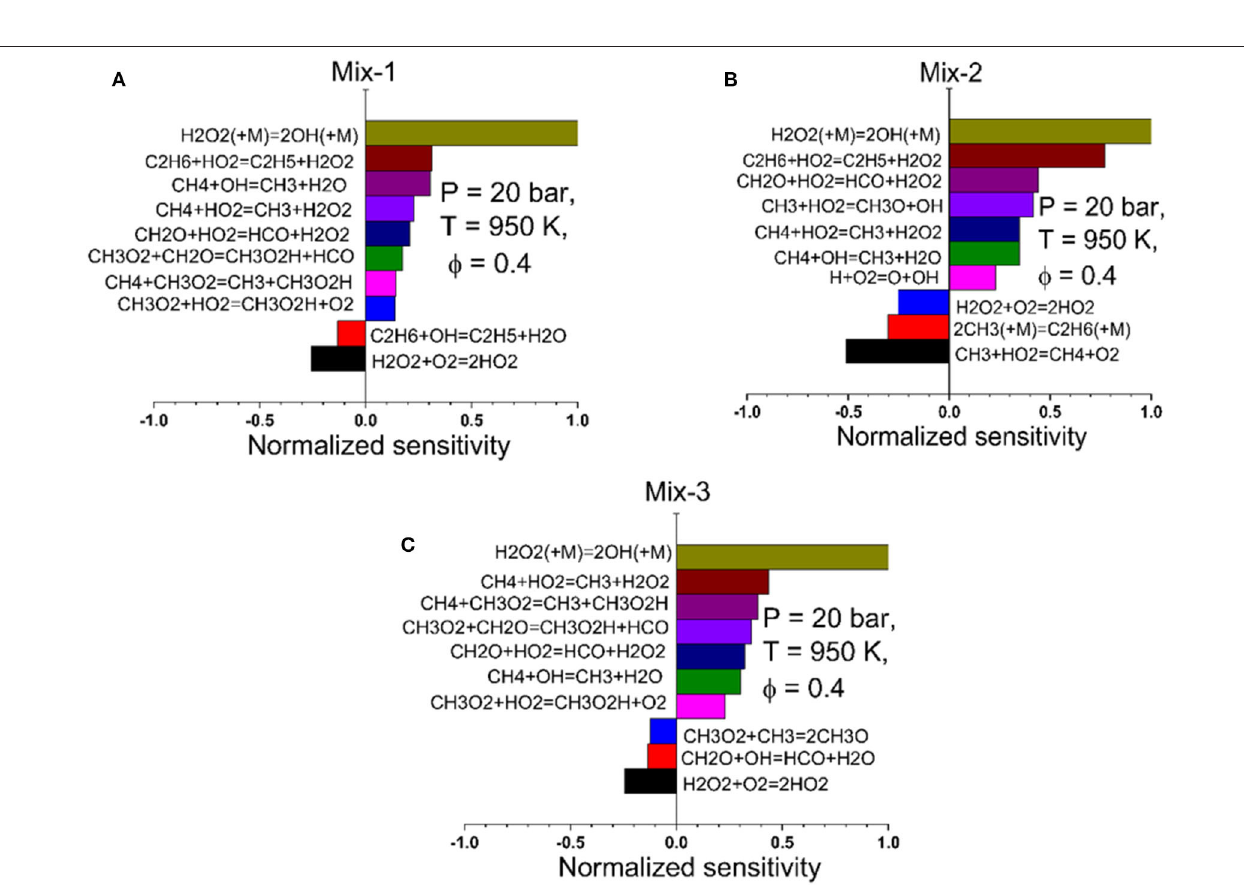
(Zhang et al., 2015) was performed to gain insights on the ignition behaviors. The following findings were obtained in this